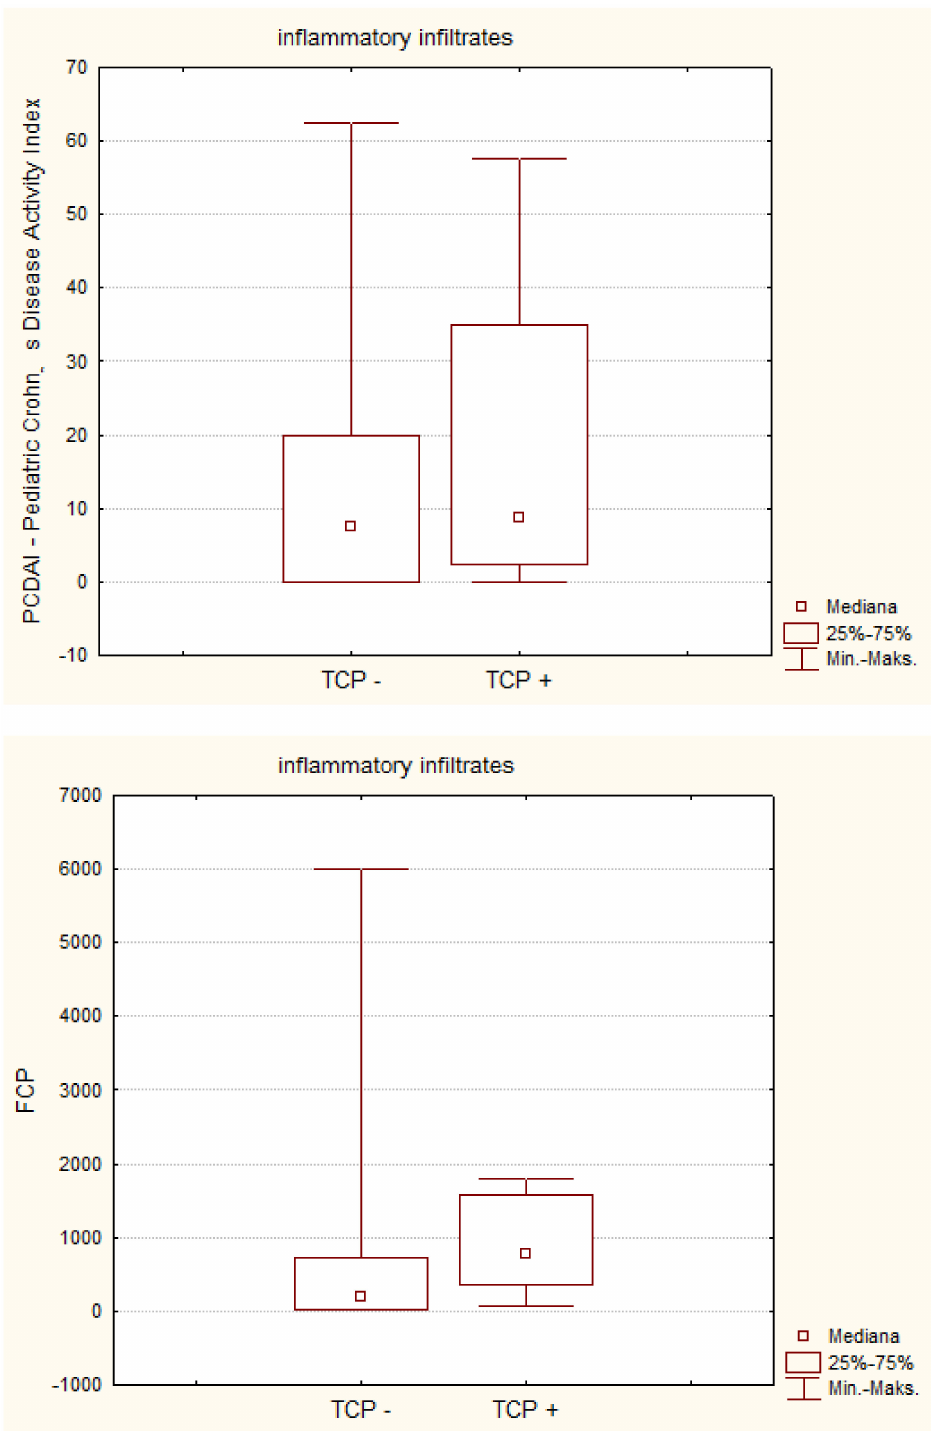
Figure 2. PCDAI and TCP in inflammatory infiltration in 57 patients included in the study; the higher the PCDAI score, the higher the TCP ( p =